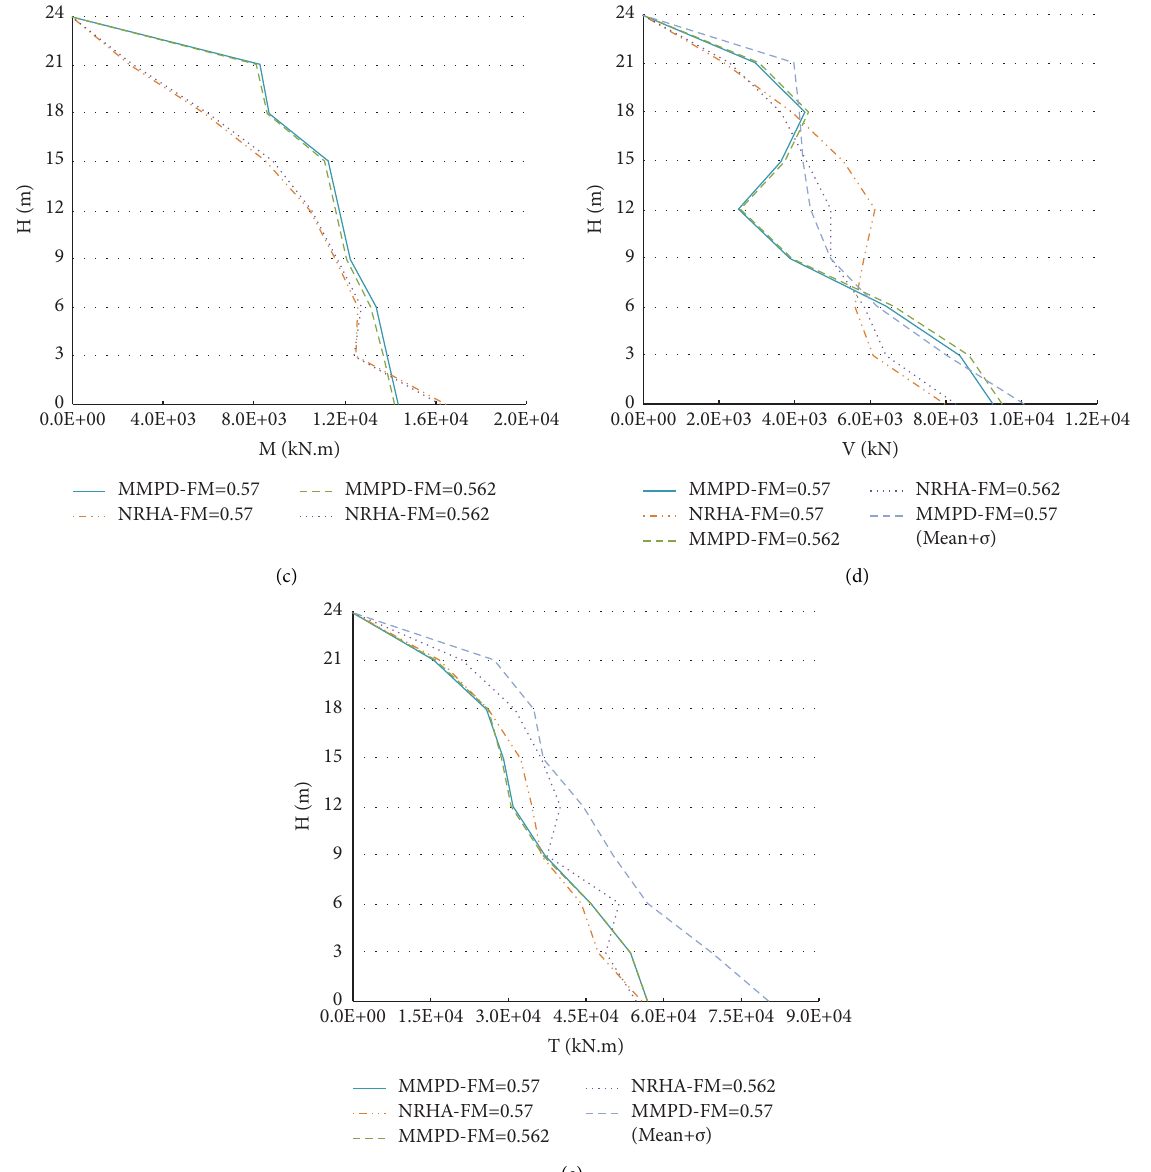
Figure 19: Building B2 under BORREGO record with diferent distributions of reinforcements: (a) comparison between NRHA and interstorey drifts limit, (b) NRHA fexural moment demands and MMPD fexural capacities of 30cm wall, (c) NRHA fexural moment demands and MMPD fexural capacities of 20cm wall, (d) NRHA/approximated MMPD shear demands, and (e) NRHA/approximated MMPD torsional